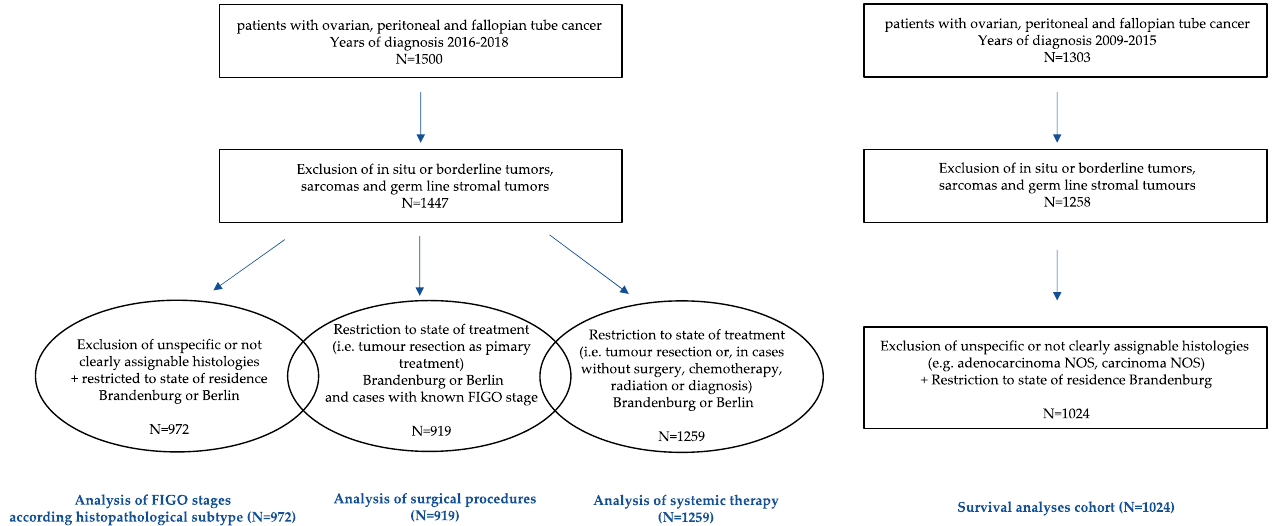
Figure 1. Flow Chart of selection criteria and process, detailed information on ICD and OPS Codes are provided as Appendix A at the end.